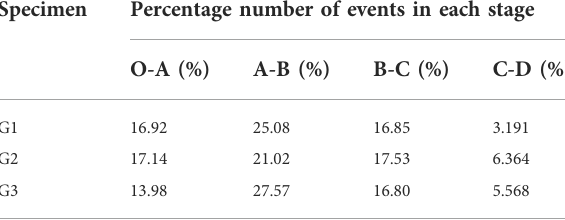
TABLE 4 Ratios of FEs in each